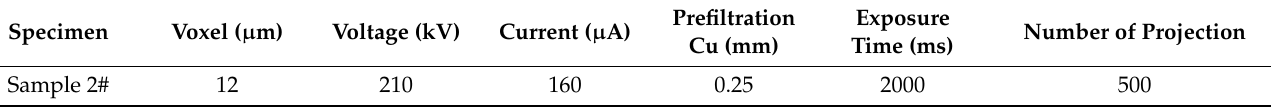
Table 3. Parameters used for XCT